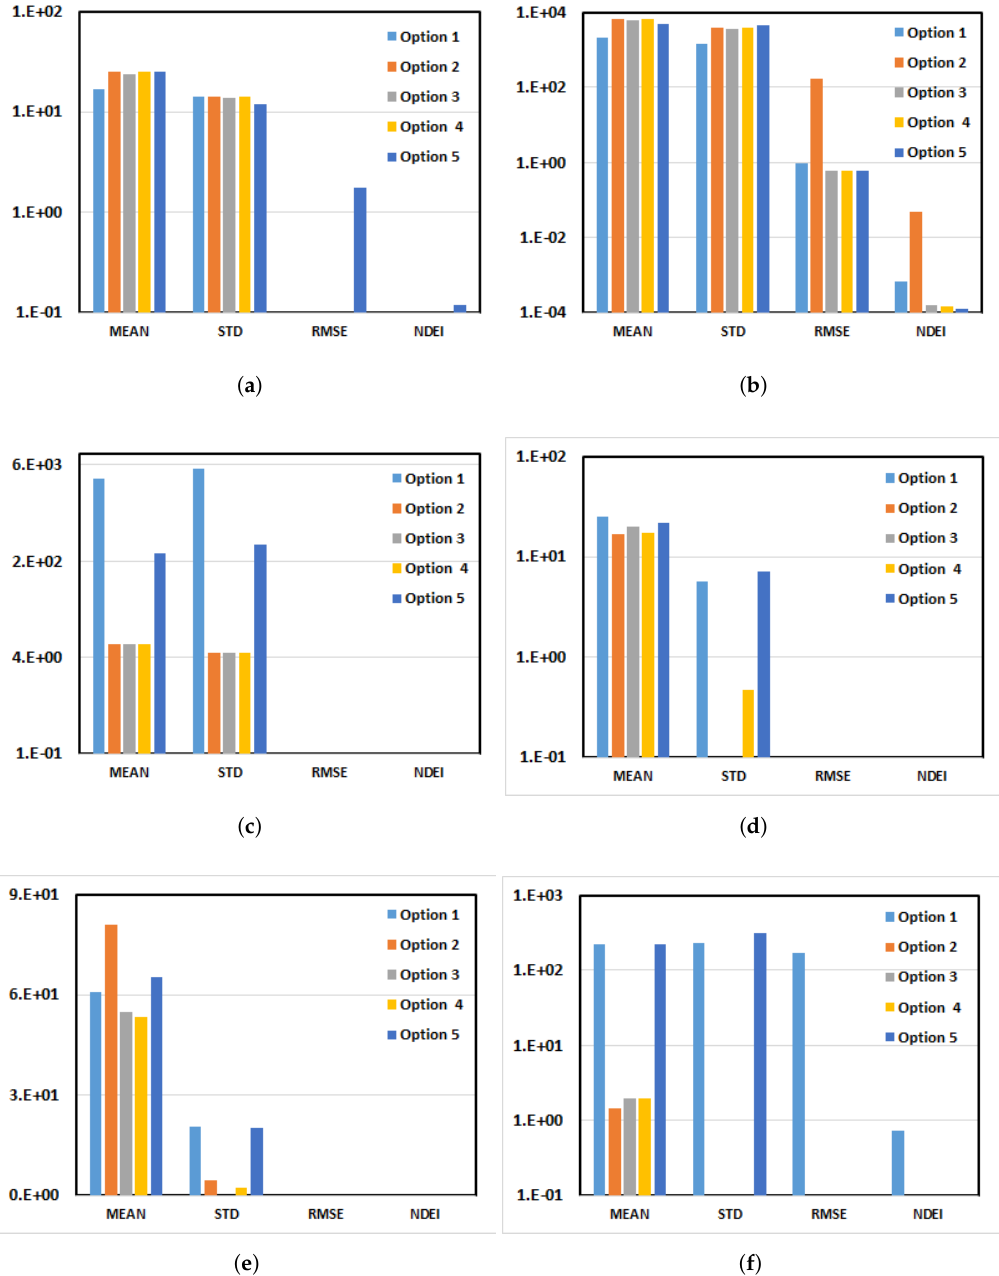
Figure A4. Statistical data plots of worldwide successful combustion injection EOR projects: ( a ) API; ( b ) depth; ( c ) permeability; ( d ) porosity; ( e ) saturation; and ( f )